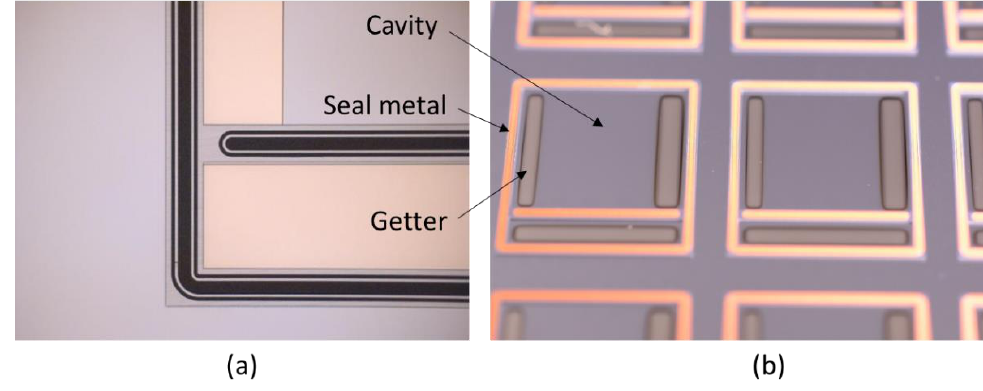
Figure 17. Images of window wafers fabricated for the wafer-level vacuum packaging (WLVP) of infrared imagers. The window wafers were coated with a thin film getter that was patterned using shadow masks during the deposition [103]. ( a ) Optical micrograph showing the location a titanium (Ti)-based thin film getter; ( b ) Optical image depicting a zirconium (Zr)-based getter.